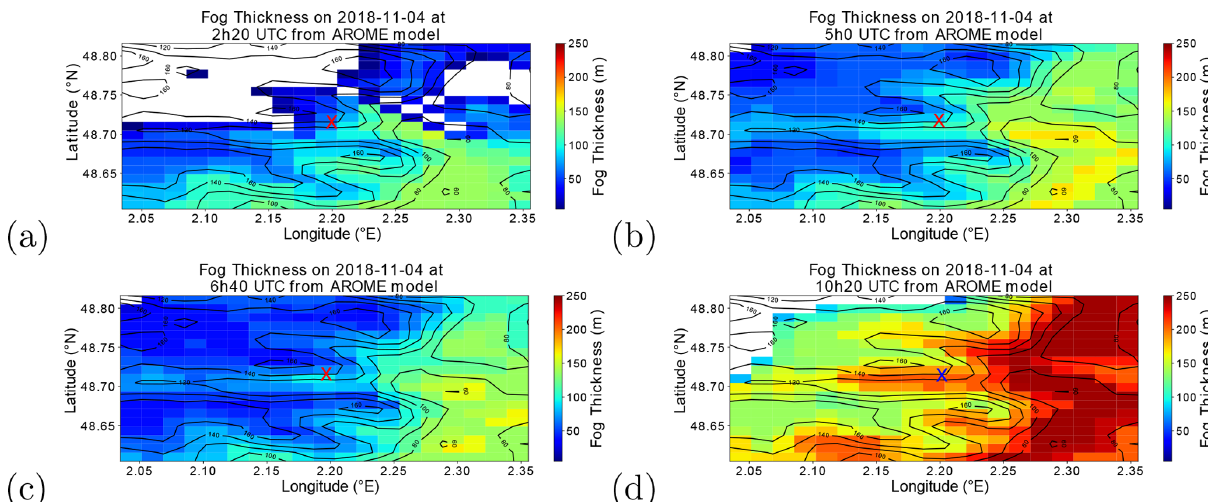
Figure 1. Fog top altitude above ground level in the AROME model during a radiative fog event (a) in the formation phase of the event at 02:20UTC, (b) in the mature phase at 05:00UTC, (c) in the mature phase at 06:40UTC, and (d) in the dissipation phase at 10:20UTC. The fog event ended at around 11:30UTC in the model. The SIRTA site is marked by the red or blue cross. Black contours represent the surface height.